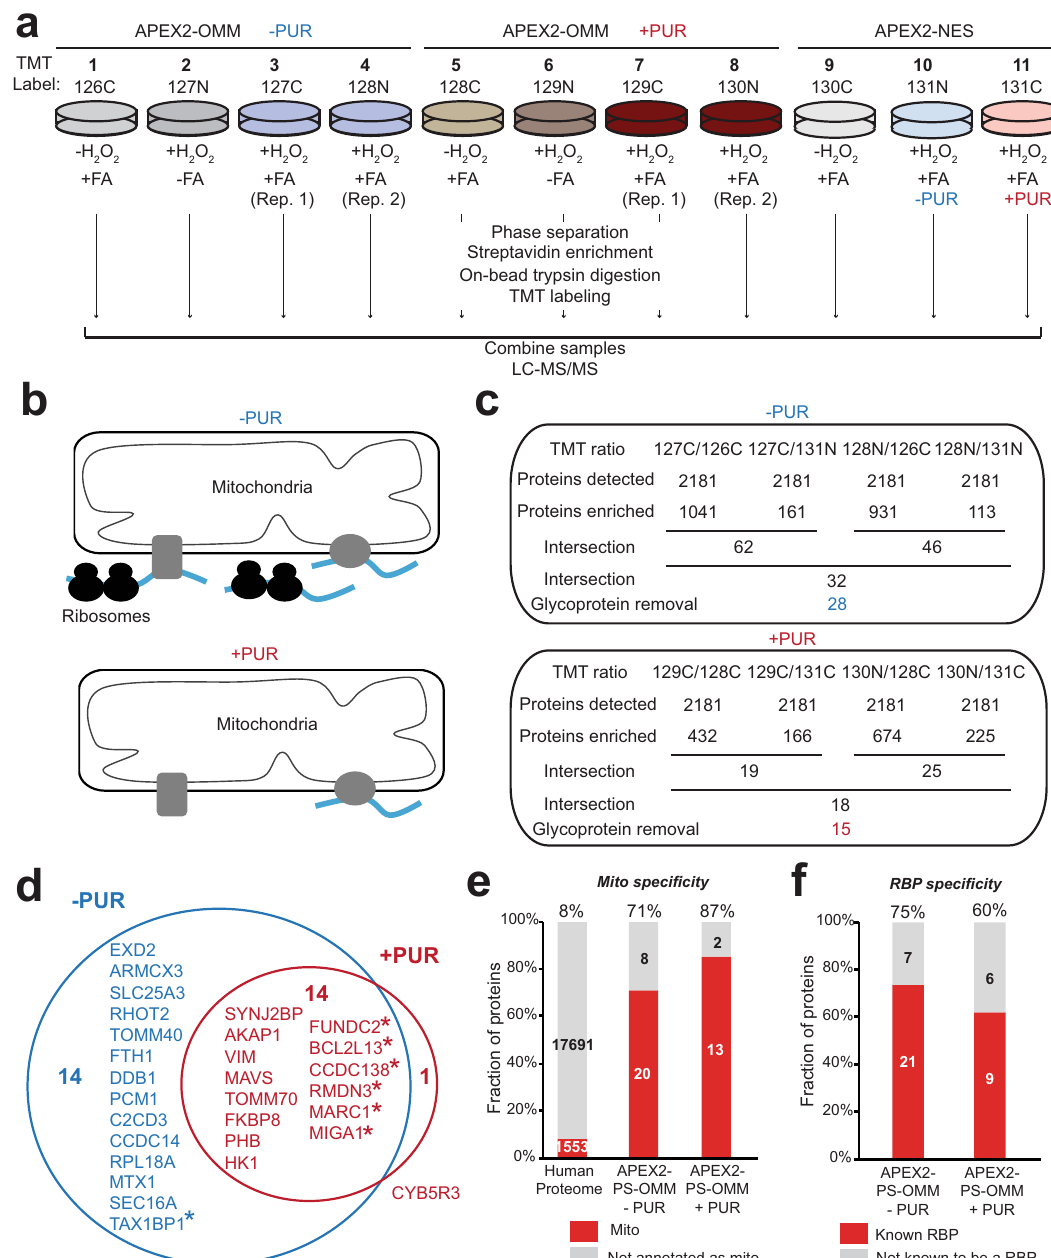
Fig. 5 Proteomic pro fi ling of RBPs localized to the outer mitochondrial membrane by APEX-PS. a Experimental design and labeling conditions for TMT- based proteomics. HEK cells stably expressing APEX2-OMM were subjected to proximity biotinylation, FA crosslinking, and enrichment according to Fig. 1a-b. The control samples omitted H 2 O 2 (samples 1 and 5) or FA (samples 2 and 6). Cytosolic APEX2-NES was included as a reference for ratiometric analysis (samples 9 – 11). b Schematic showing expected changes at the OMM upon treatment with puromycin (PUR), which inhibits protein translation and disrupts polysomes. Blue lines, RNA. Gray shapes, potential RBPs. c Numbers of proteins remaining after each step of fi ltering the mass spectrometric data. The fi nal nuclear − PUR and + PUR OMM RBP proteomes obtained by APEX-PS have 28 and 15 proteins, respectively. d Overlap of OMM-localized RBPs under basal and + PUR conditions. RBP orphans (proteins with no previous RNA-binding annotation in literature) are starred. e Mitochondrial speci fi city of OMM RBPs identi fi ed by APEX-PS. For comparison, same analysis was performed on entire human proteome. f RBP speci fi city of APEX-PS OMM datasets. Details in Supplementary Data